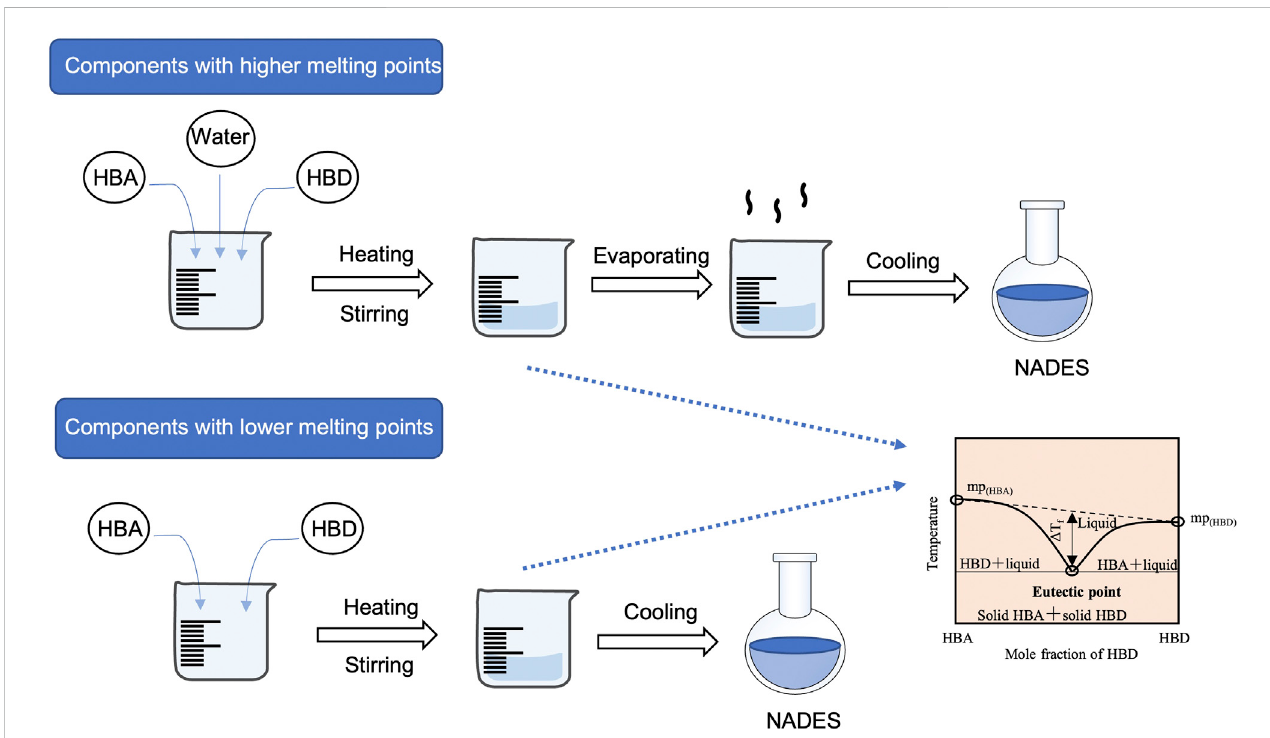
FIGURE 2 Preparation of NADES with components with higher/lower melting points. HBA, hydrogen bond acceptor; HBD, hydrogen bond donor; NADES, natural deep eutectic solvents.